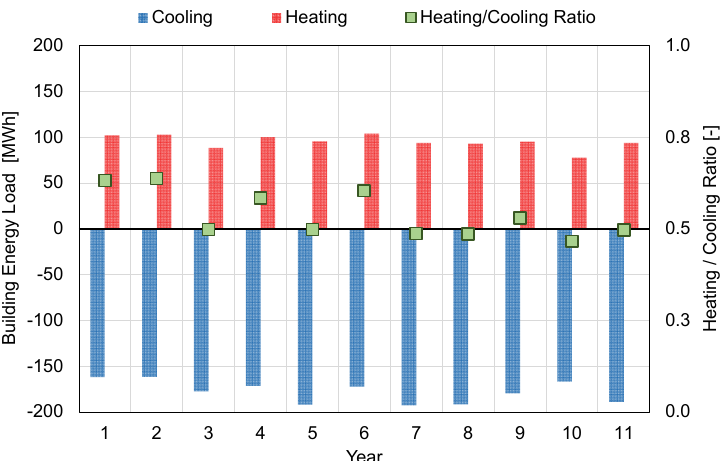
Figure 5. Calculated annual thermal load of the building from 2005 to 2016 and heating to cooling energy demand ratio. Table 1. Characteristics of the old and new heat pump.